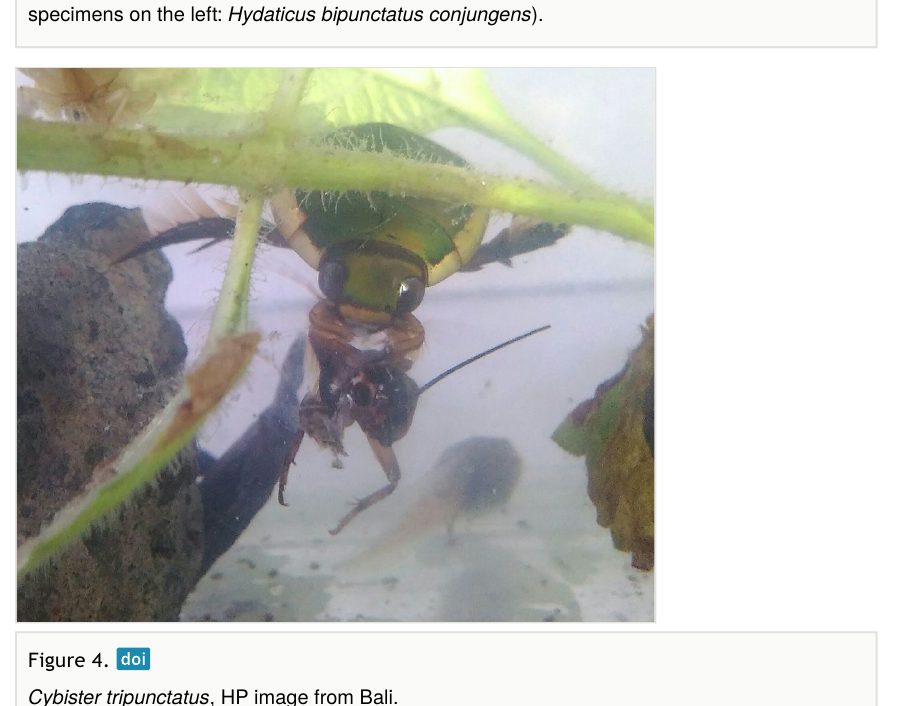
Figure 4. Cybister tripunctatus , HP image from